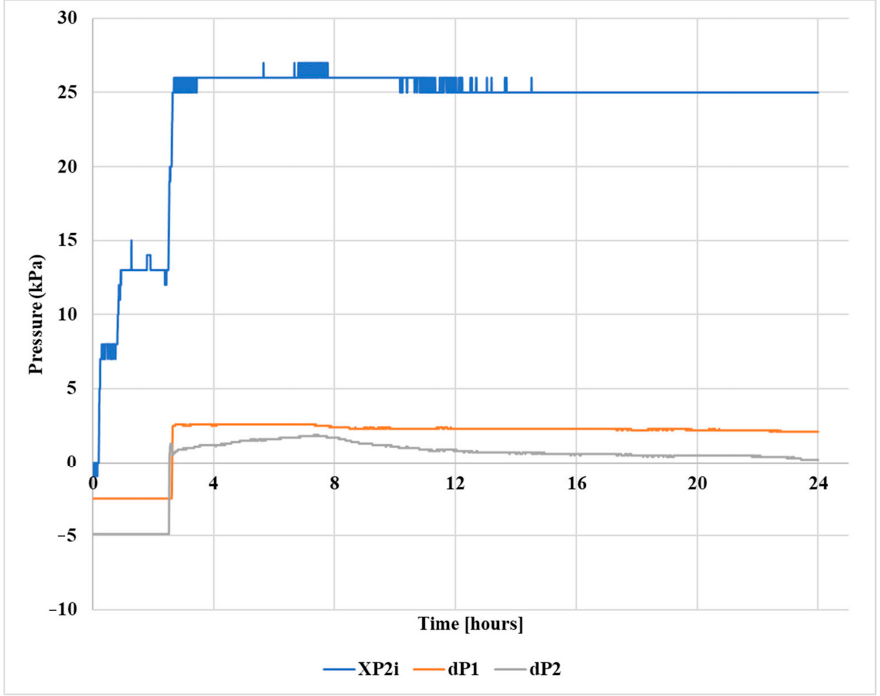
Figure 13. Recorded pressure during an experiment in a column deviated 40 ◦ from vertical using the laponite gel pill. The bottom hole pressure is shown as the blue line. The differential pressures dP1 and dP2 are shown as the orange and gray lines, respectively.